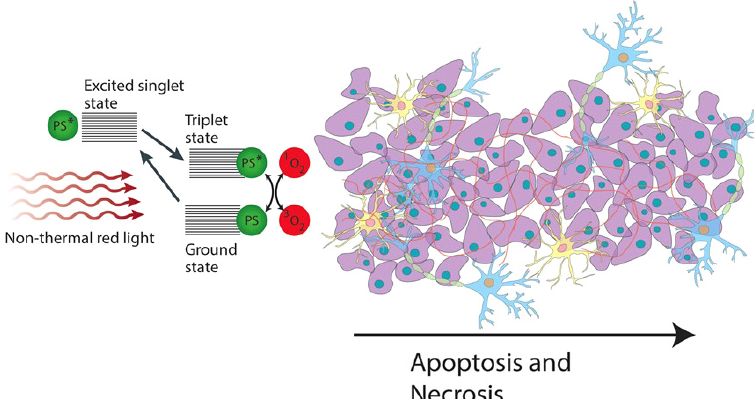
Fig. 1. Overview of PDT mechanism in the brain. Here we are demonstrating a mixed tissue volume similar to that seen beyond the resection boundary where there is a mix of tumor cells (purple cells in illustration) and neuronal cells (blue and yellow cells in illustration).